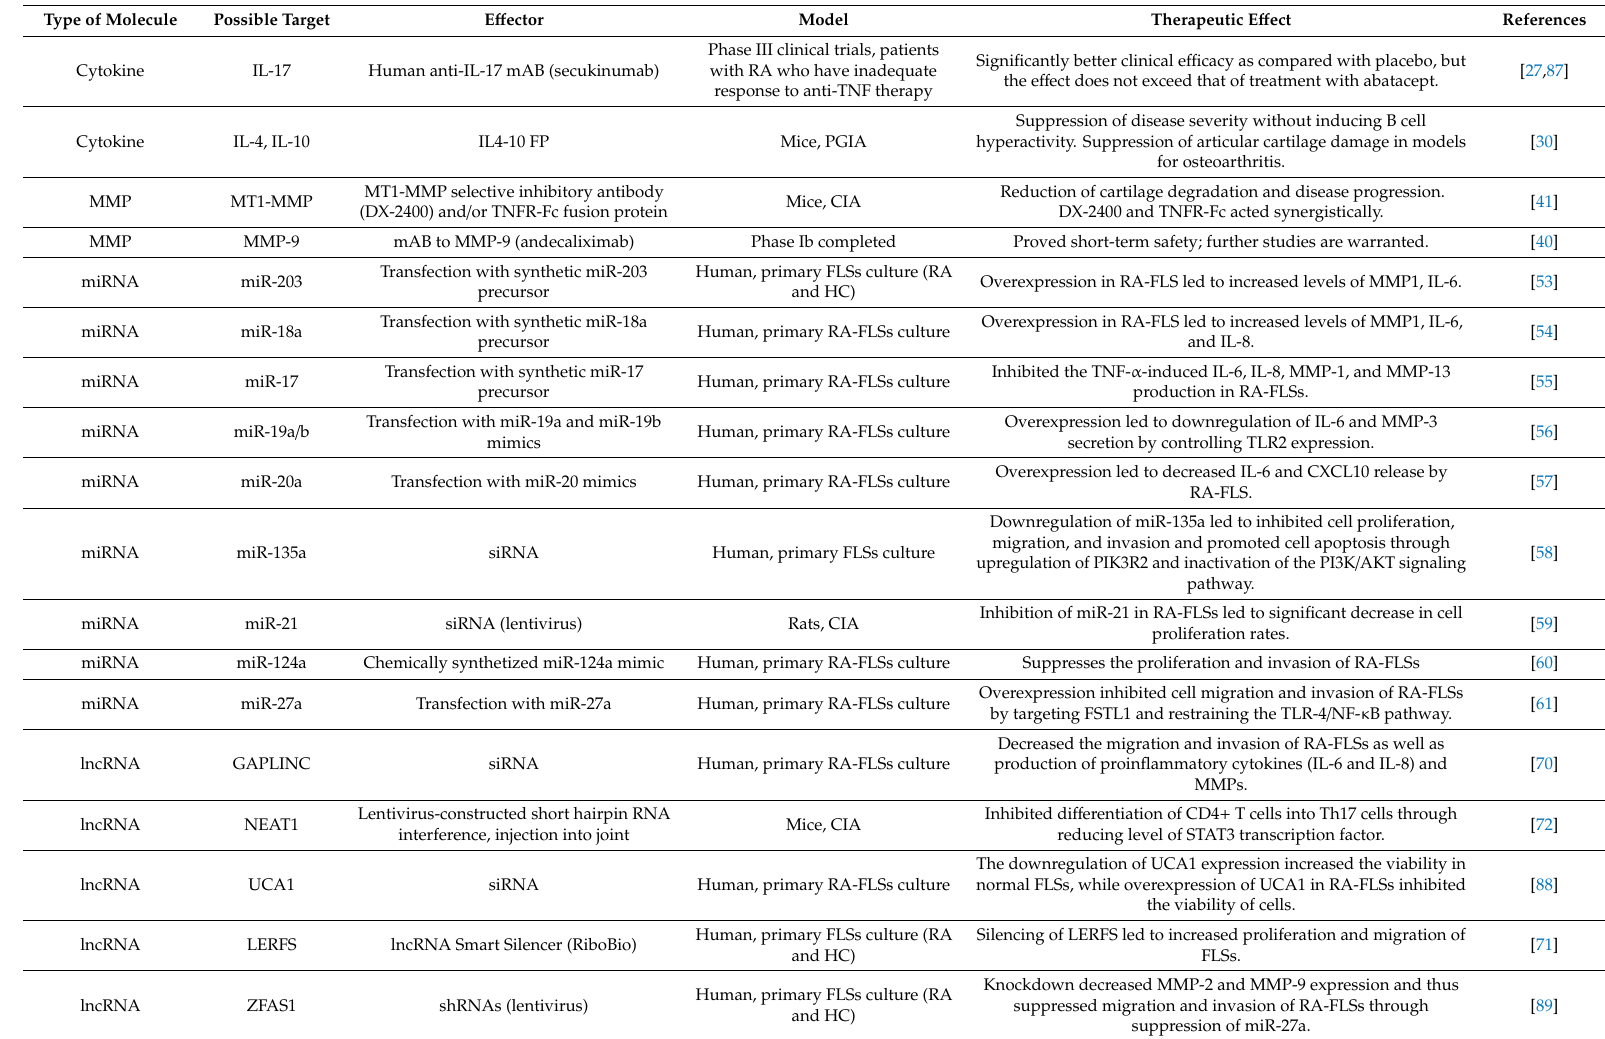
Table 1. Possible novel targets for rheumatoid arthritis (RA)